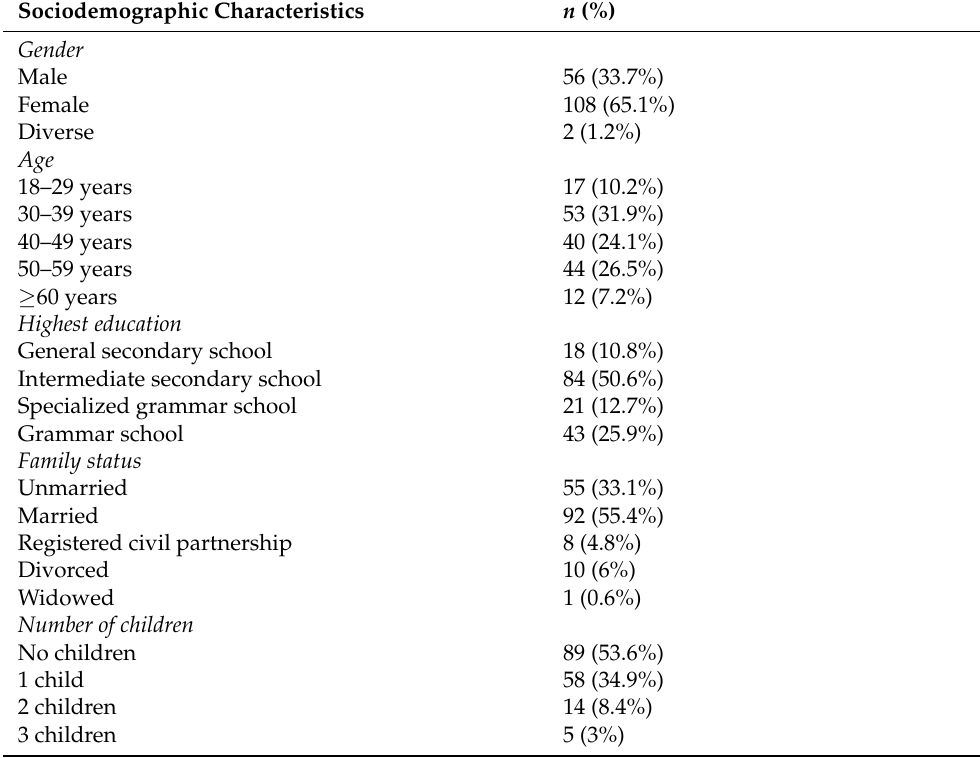
Table 1. Sociodemographic